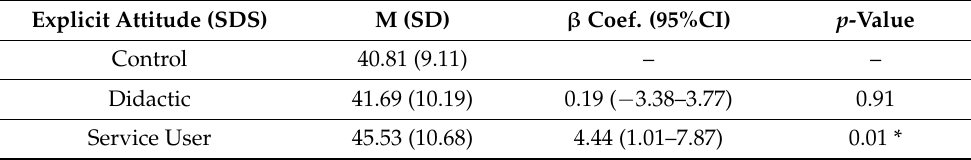
Table 7. Personal experience with mental illness adjusted model ( n =